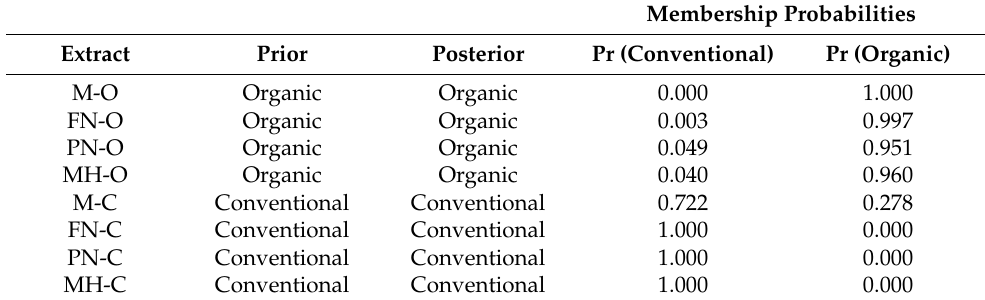
Table 10. Prior and posterior classification of the red grape pulp extracts using PC-DA (Raman spectral